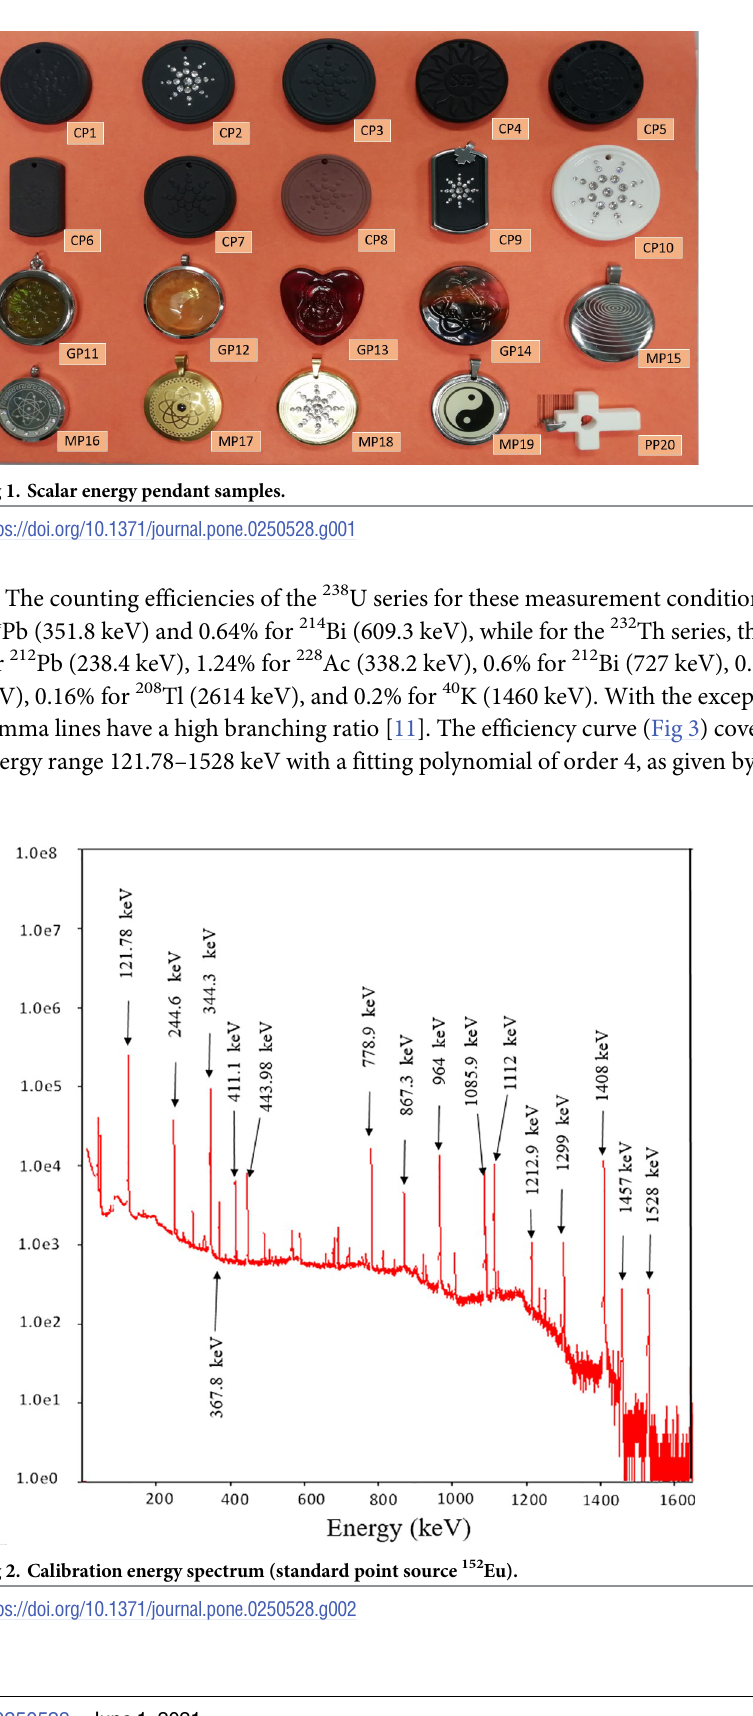
Fig 2. Calibration energy spectrum (standard point source 152